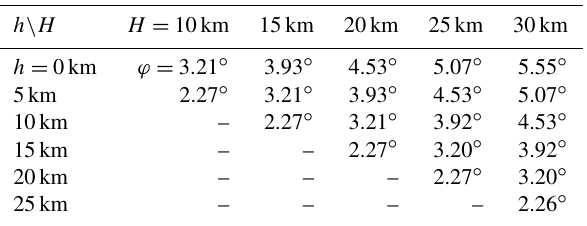
Table 1. The observed height h and angular displacement ϕ for the cloud with true height H